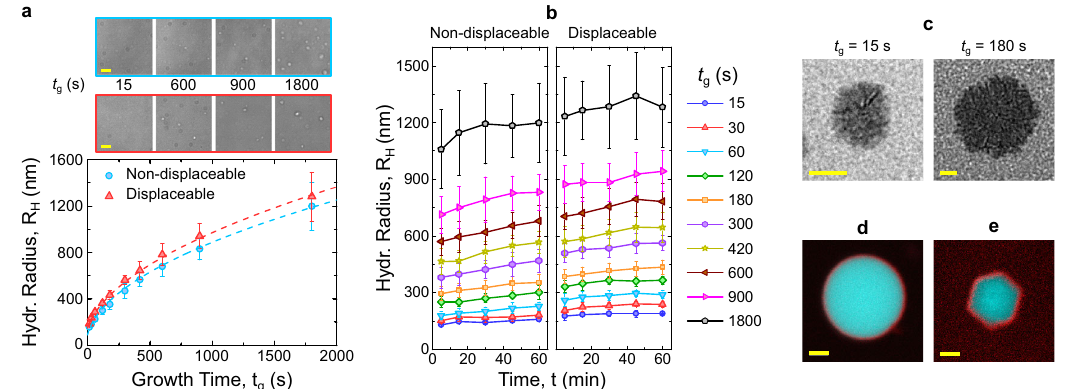
Fig. 2 Multi-stage annealing protocol produces stable particles of programmable size. a Hydrodynamic radius R H of protected particles with displaceable and non-displaceable corona (see Fig. 3a) as measured as a function of growth time t g using differential dynamic microscopy (DDM) (Bottom). Particle size can be prescribed by tuning t g . Data are shown as mean ± standard deviation calculated over 3 (non-displaceable) and 4 (displaceable) independent repeats, each point representing the R H value depicted in panel ( b ) at the delay time of 60 min. Dashed lines are fi ts to a diffusion-reaction growth model (see Supplementary Discussion 1). (Top) Bright- fi eld snapshots from the videos used in the DDM analysis, showing visibly larger aggregates for increasing t μ m. b Time dependence of R g . Contrast has been enhanced to enable visualization. Scale bars 5 H in protected particles with displaceable and non- displaceable corona as measured with DDM at room temperature. Data are shown as mean ± standard deviation as in panel ( a ). A limited increase in size is observed, demonstrating particle stability against coalescence. Supplementary Fig. 7 proves longer-term particle stability. c TEM micrographs of protected particles assembled at two different t g values. Selected micrographs represent data obtained in a single experiment. Scale bars 200 nm. d Confocal micrograph of a large aggregate assembled via a slow quenching protocol (see Methods), highlighting the core – shell structure. Scale bar 2 μ m.